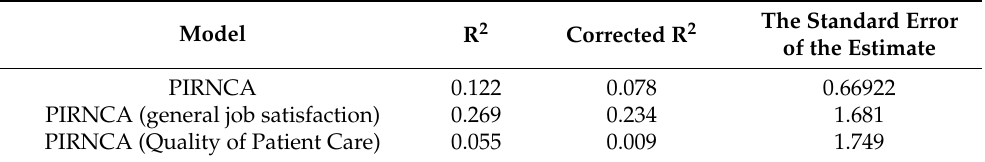
Table 6. Matching model of the impact of sociodemographic data on rationing of nursing care, overall job satisfaction, the quality of patient